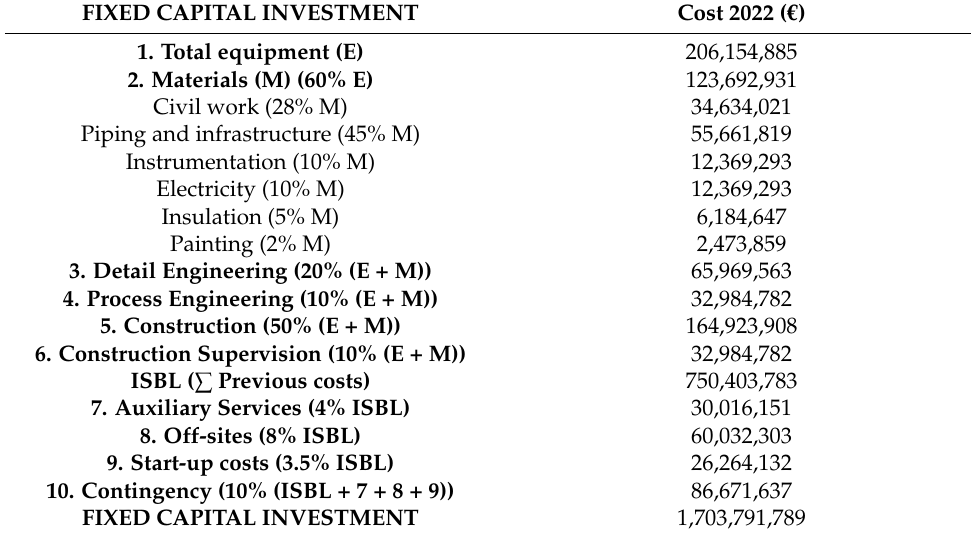
Table 8. Fixed capital Investment.